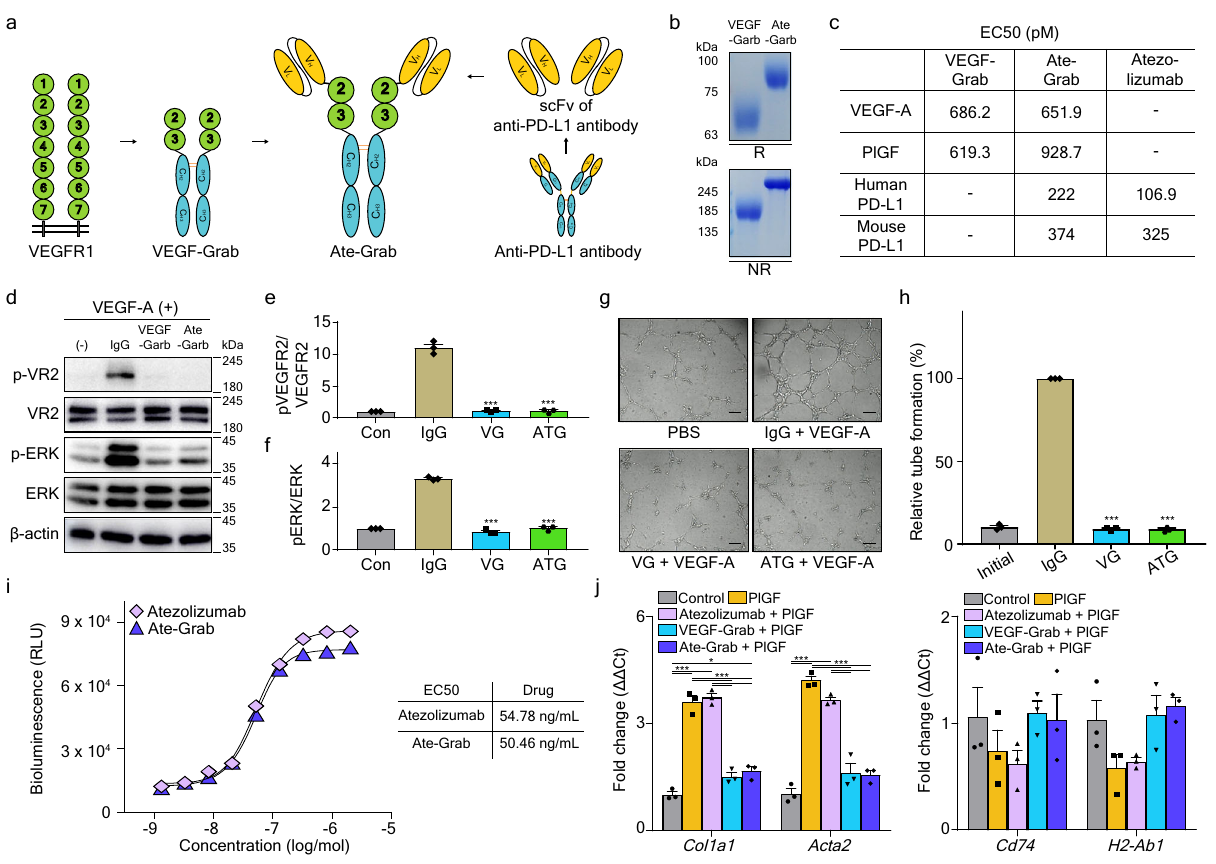
Fig.3|Ate-Grabisamulti-paratopicdecoyreceptorthatcantargetbothPlGF/ VEGF-AandthePD-1/PD-L1axis.a SchematicdiagramoftheAte-Grabdesign.The single-chainvariablefragmentofatezolizumabwitha[G4S]3linkerwasfusedtothe N-terminus of VEGF-Grab. b Representative image of SDS-PAGE analysis on VEGF- Grab and Ate-Grab. Both reducing and non-reducing conditions were usedfor 10% acrylamide gel electrophoresis, and products were visualized through Coomassie bluestaining.R,Reducingcondition;NR,Non-reducingcondition. c Targetbinding af fi nitiesofAte-GrabandtemplatedrugsassessedviaELISA. d Westernblotanalysis for phospho-VR2, VR2, phospho-ERK, ERK, and β -actin after treatment with IgG, VEGF-Grab (VG), Ate-Grab (ATG), or without any treatment (control) in HUVECs incubated with VEGF-A.Total and phosphorylated levelsof VEGFR2 (VR2) and ERK were detected. The experiment was repeated for three times independently with similar results. Relative quantities of e phospho-VEGFR2/VEGFR2 and f phospho- ERK/ERK across control, IgG, VG, and ATG groups. Data from three biological